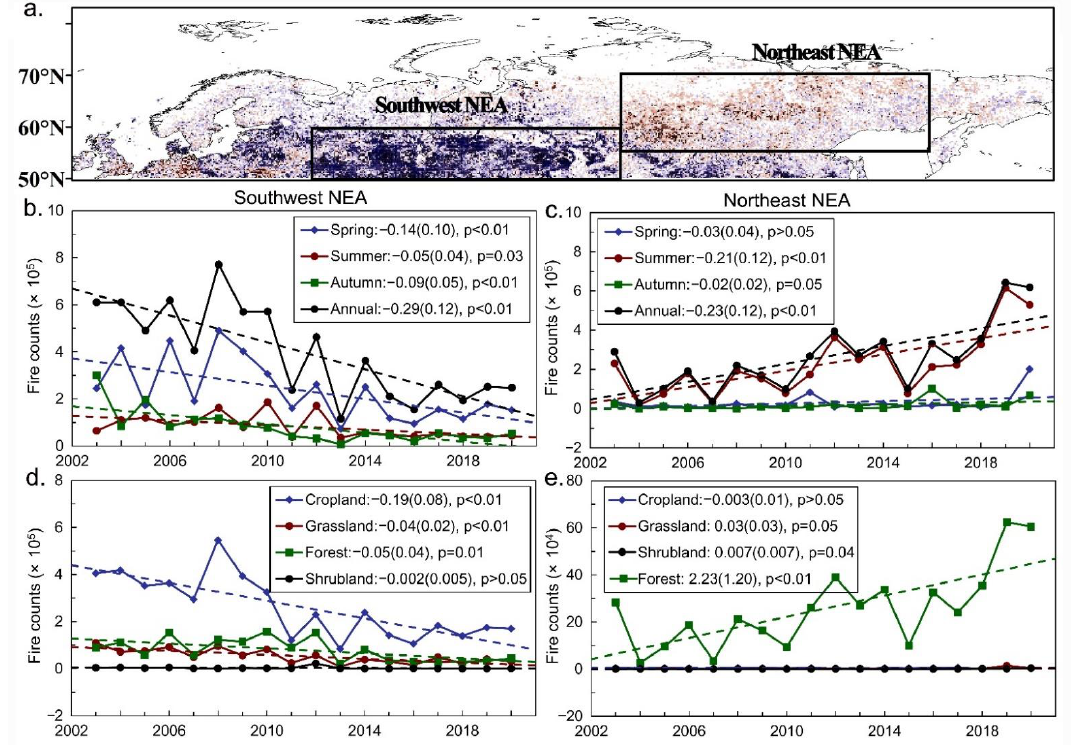
Figure 8. Statistical variations in wildfire counts in the southwestern and northeastern NEA. ( a ) Locations of the two sub-regions. ( b ) and ( d ) inter-annual variations in active fire counts in southwestern NEA for different seasors and land cover types, respectively; ( c ) and ( e ) Inter-annual variations in active fire counts in northeastern NEA for different seasons and land cover types, respectively. Table 3. Proportions of land cover types and changes in fire counts in southwestern and northeastern NEA.